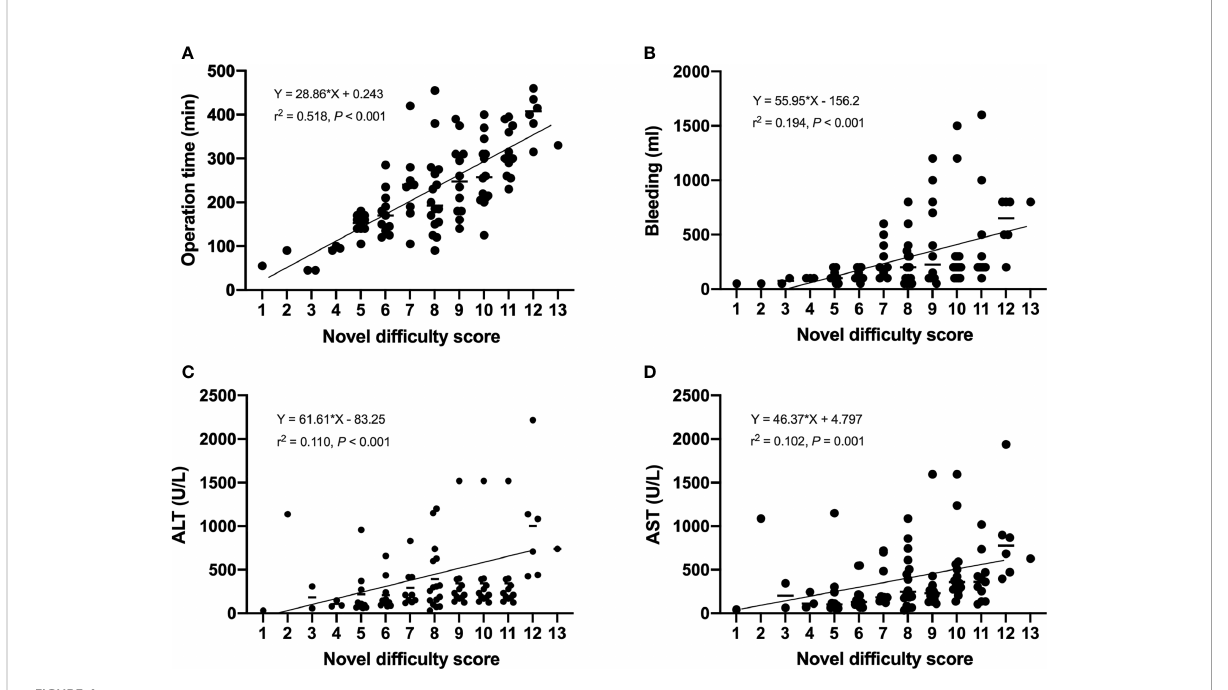
FIGURE 4 Operation time (A) , bleeding (B) , ALT (C) , and AST (D) according to dif fi culty score.